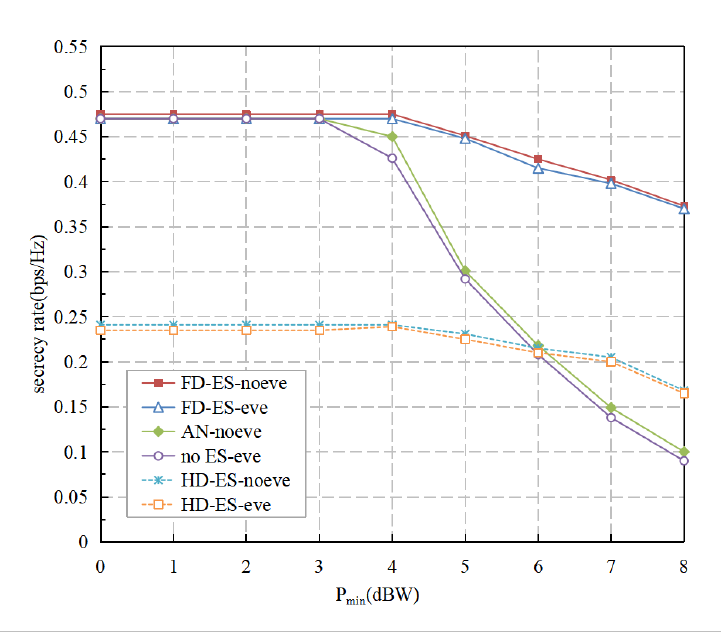
Figure 5. Secrecy rate vs. minimum essential energy at